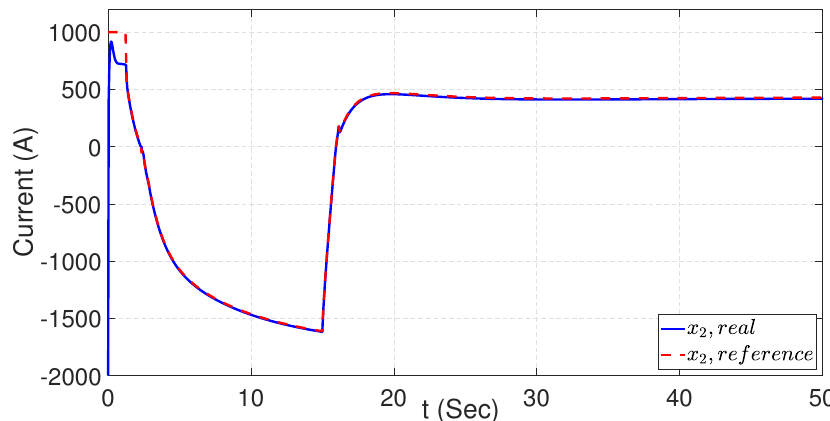
Figure 8. AES current control during regenerative